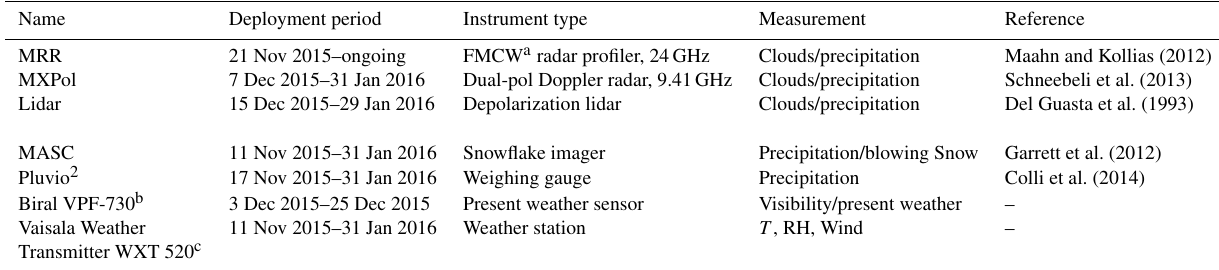
Table 1. Nonexhaustive list of the instruments deployed at DDU in the framework of APRES3. Only the APRES3 instruments with a certain relevance for precipitation monitoring are listed here.